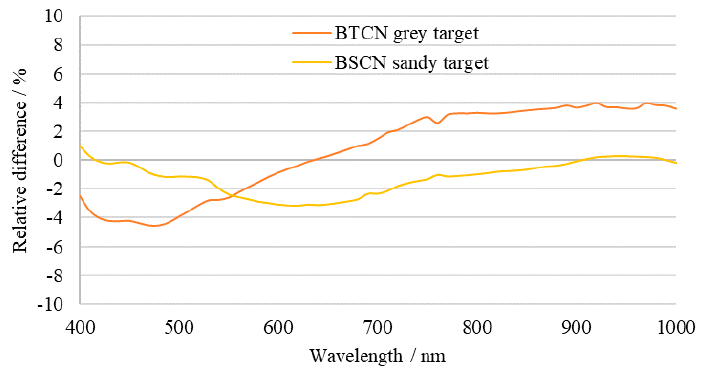
Figure 15. Difference of top-of-atmosphere (TOA) reflectance between correcting and not correcting for background adjacency effect for BTCN and BSCN targets.